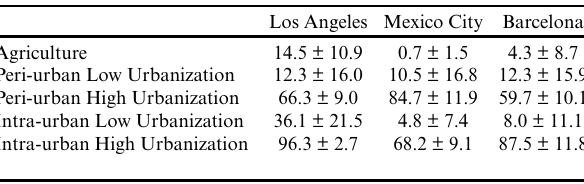
Table 2 . Built cover (average ± SD) of the sites in which we surveyed House Sparrows ( Passer domesticus ) by city and “land class.”